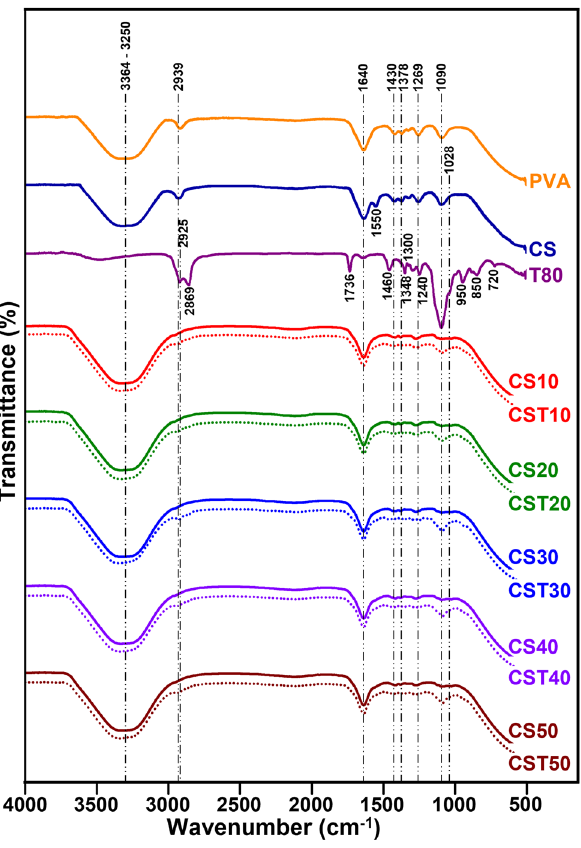
Figure 2: FTIR spectra of the PVA nano fi ber mat, CS powder, T80 powder, and the nano fi ber mats prepared in various conditions with ( dashed lines ) and without ( solid lines ) T80